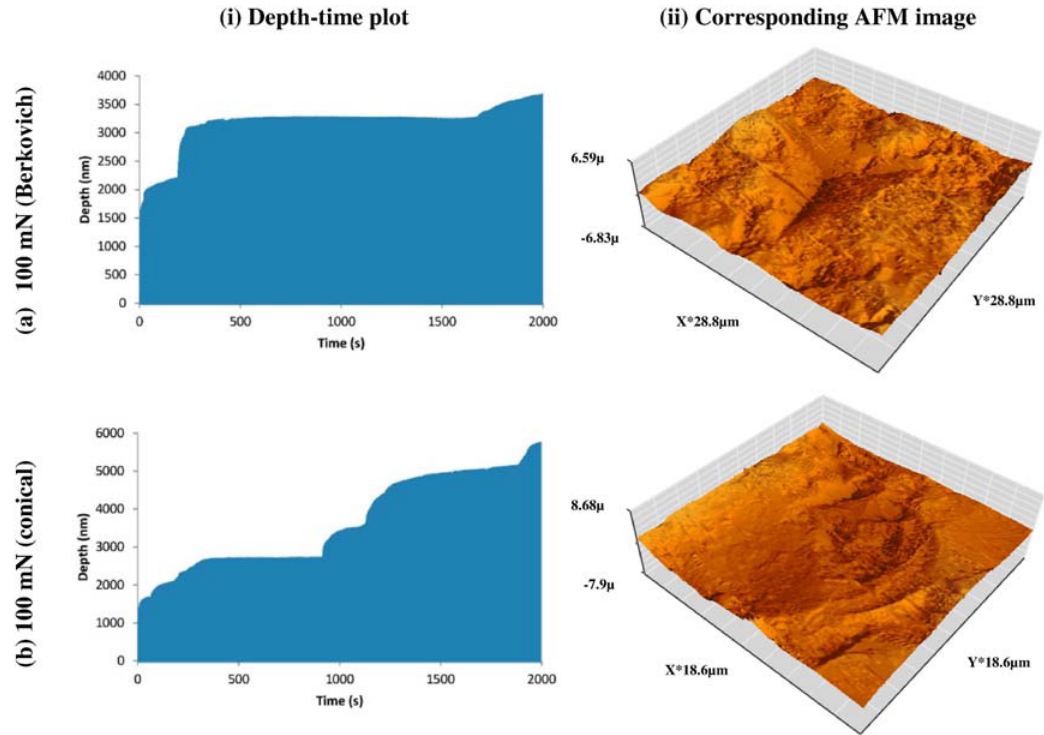
Figure 6. Nano-impact testing at the highest load of 100 mN: ( i ) Full record of impact depth-time measurement; ( ii ) corresponding AFM image of residual